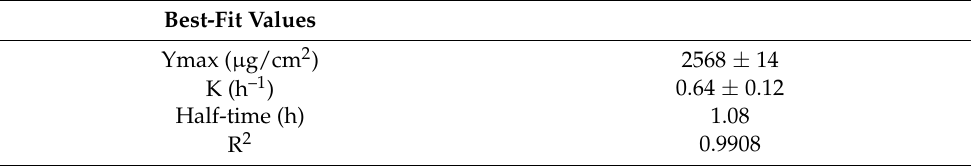
Figure 4. Cumulative amount of ketorolac released. Data followed a first-order (One-phase exponen- tial association) kinetics. Values represent Means ± SD ( n = 6). Table 1. Drug release parameters from KT hydrogel according to a first order kinetics. Ymax = total amount of drug released; K = release rate constant. Values represent Means ± 95% confidence interval ( n =